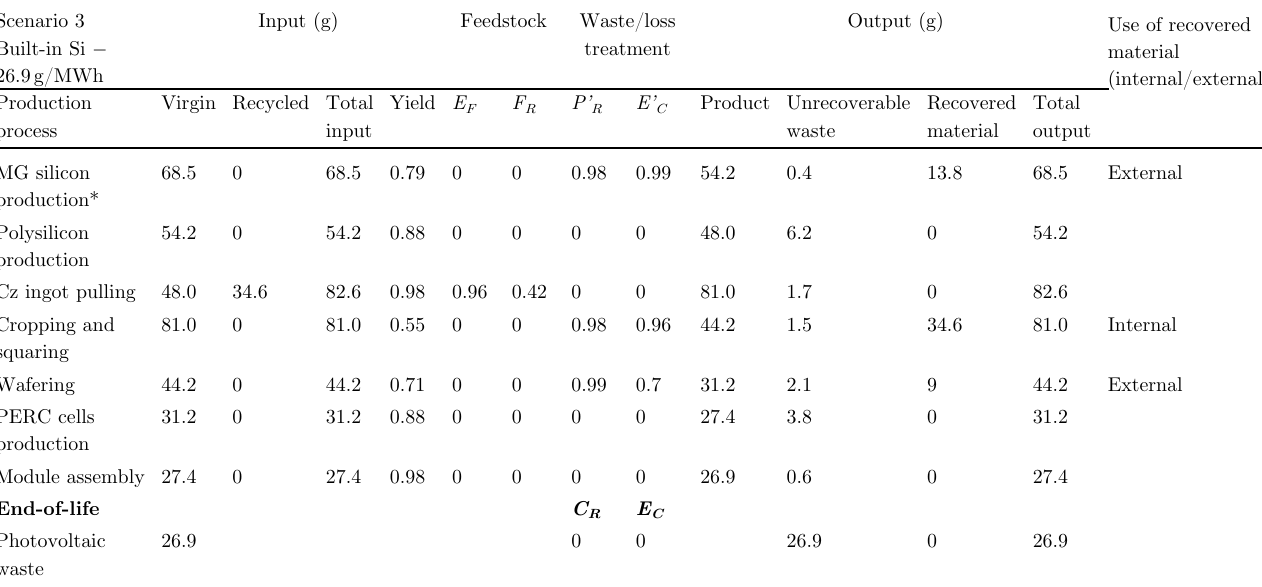
Table A3. Material fl ows for 2032 ITRPV projection/Business-as-usual scenario. Scenario 3 Built-in Si